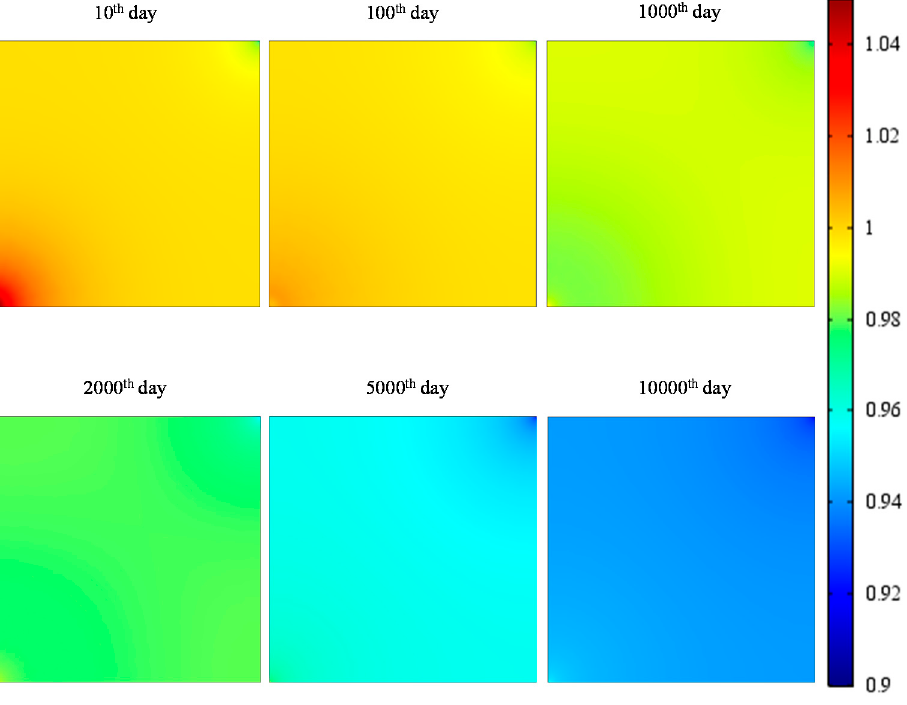
Figure 5. Fracture permeability evolution maps ( k f / k f 0 ) at different time. 3.1.1. Matrix Permeability Evolution On the 10th day, the decrease in effective stress due to the increase in pore pressure caused by the injected gas will expand the pores and cause the increase of permeability near the IW. Conversely,